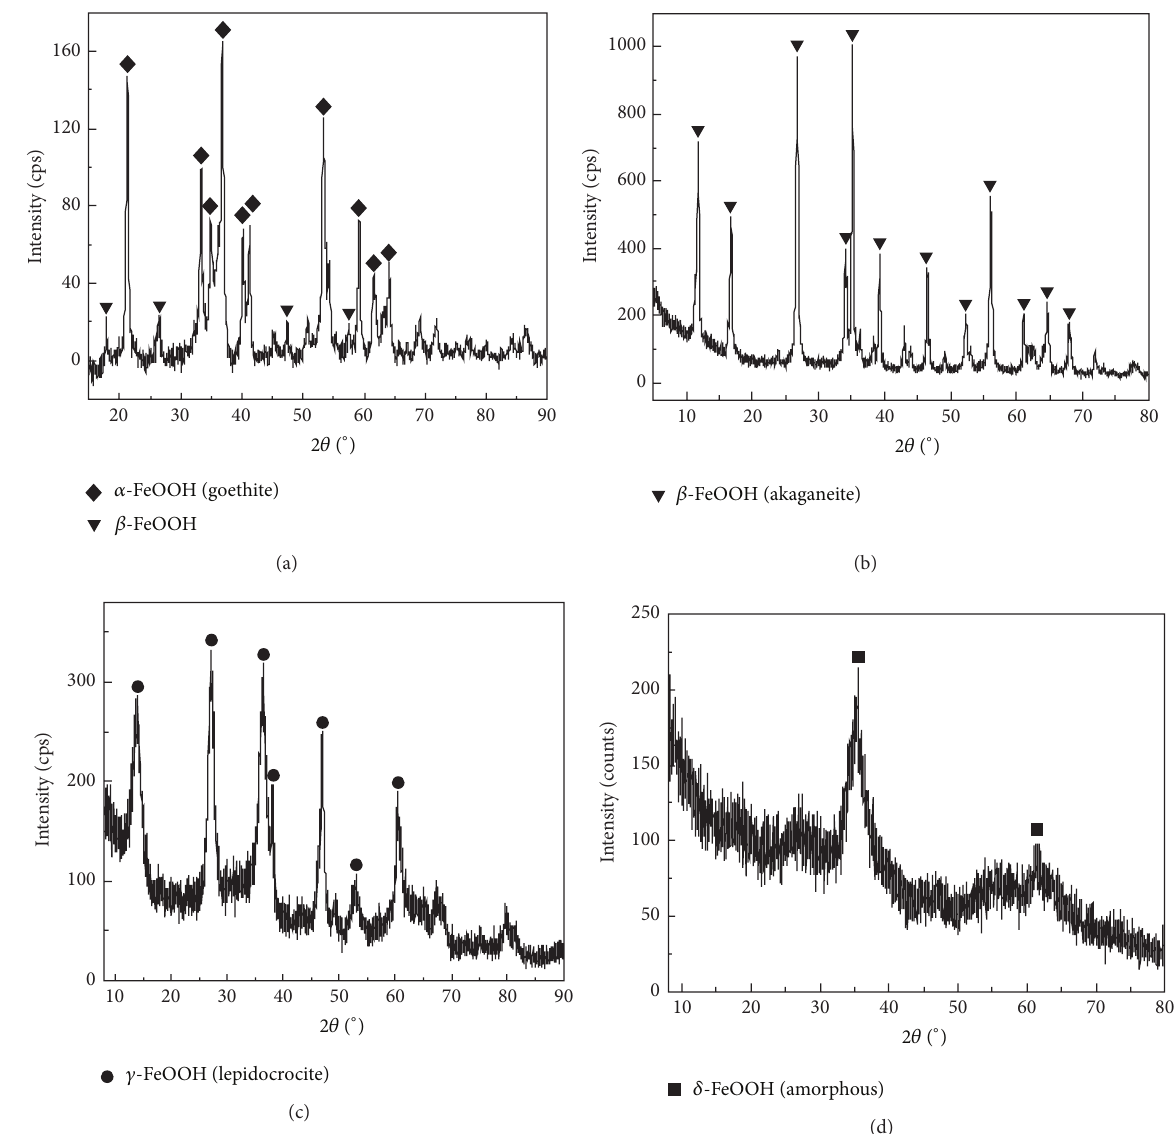
Figure 3: X-ray diffraction patterns of different forms of FeOOH. X : 𝛼 -FeOOH; 󳶃 : 𝛽 -FeOOH; e : 𝛾 -FeOOH; ◼ : 𝛿 -FeOOH.